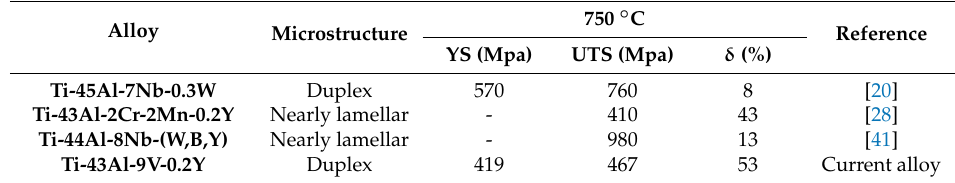
Table 2. Microstructure and tensile properties compared with other TiAl alloys.